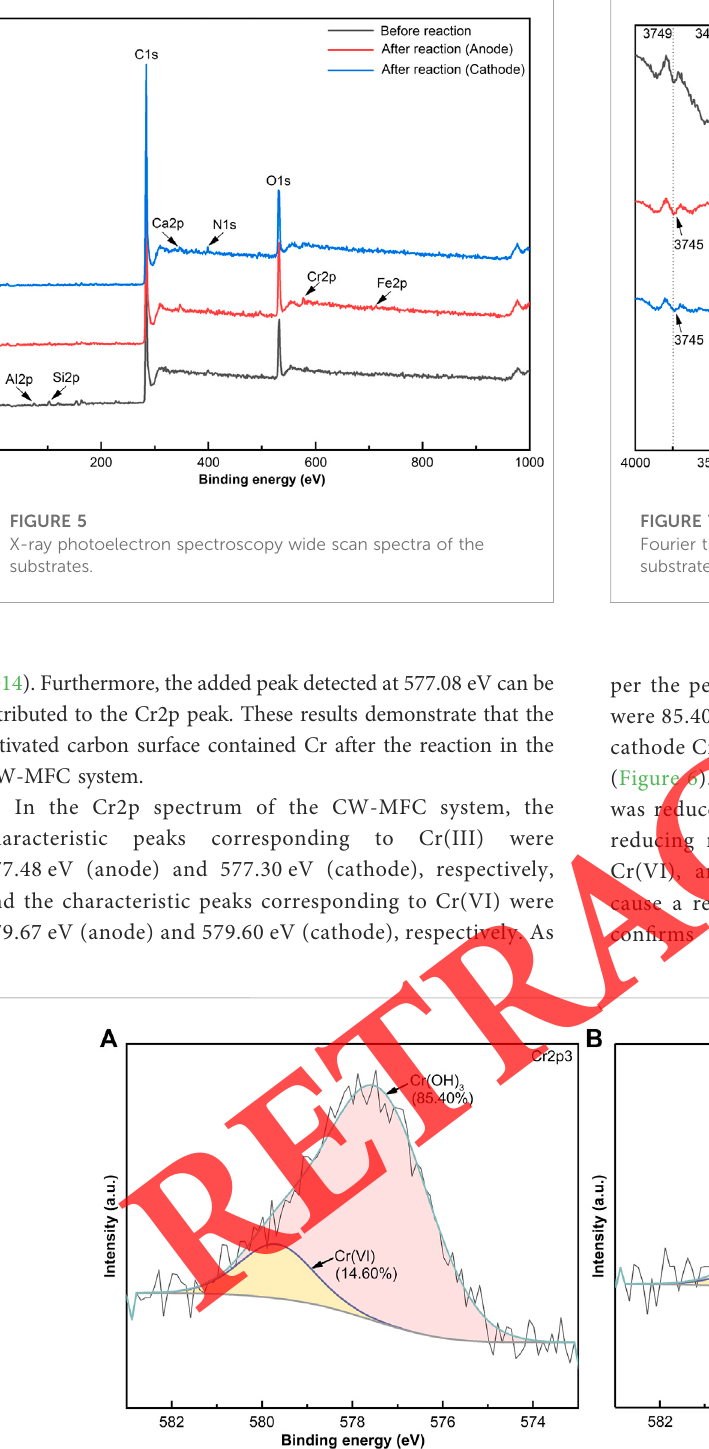
High-resolution X-ray photoelectron spectroscopy spectra of Cr2p3 after the adsorption of Cr(VI) by the constructed wetland-microbial fuel cell system: (A) anode, (B) cathode.